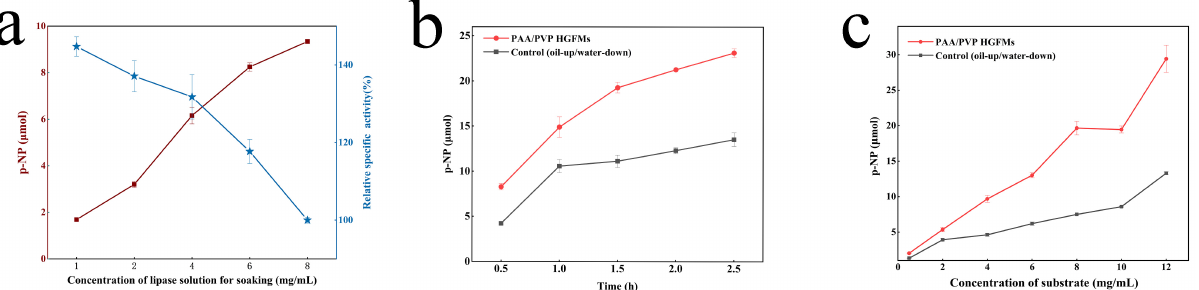
Figure 7. The catalytic capacity of the PAA/PVP HGFMs varied with different experimental factors: ( a ) the concentration of the lipase solution used to soak the HGFMs, ( b ) time during catalytic reaction process and ( c ) the substrate concentration used in the catalytic reaction process. All the HGFMs were prepared using an electrospinning speed ratio of PAA/PVP of 5/8. A thermal crosslinking time of 45 min and a UV crosslinking time of 15 min were used. An electrospinning time of 8 h was